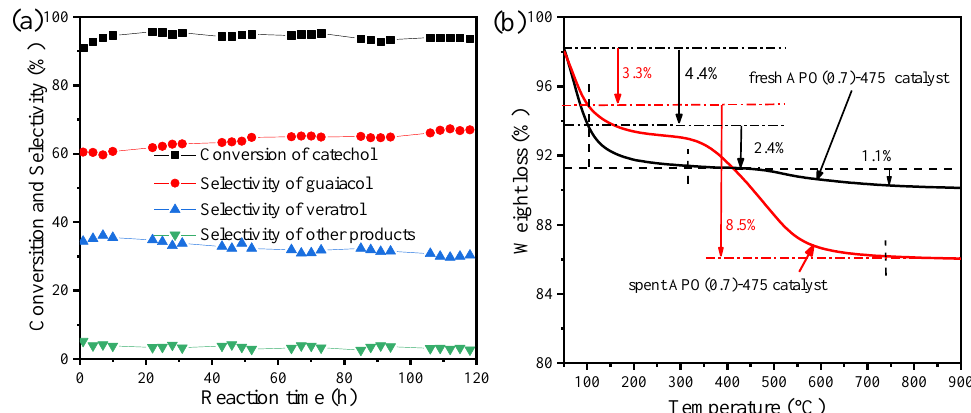
Figure 7. ( a ) Stability test of APO(0.7)-475 for the selective O -methylation of catechol with DMC to guaiacol. Reaction condition: 3 g APO catalyst, molar ratio of catechol to DMC = 1: 6, 300 ° C, LHSV = 0.4 h − 1 . ( b ) TG profiles of the fresh and spent APO(0.7)-475.